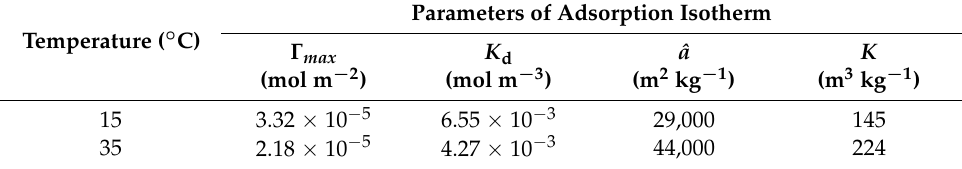
Table 1. Parameters â and K calculated from the parameters Γ max and K d , estimated by the Langmuir adsorption